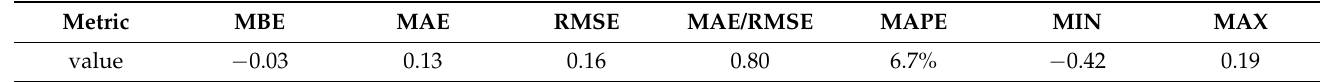
Table 12. Accuracy metrics to assess the goodness of fit of the MARS model.